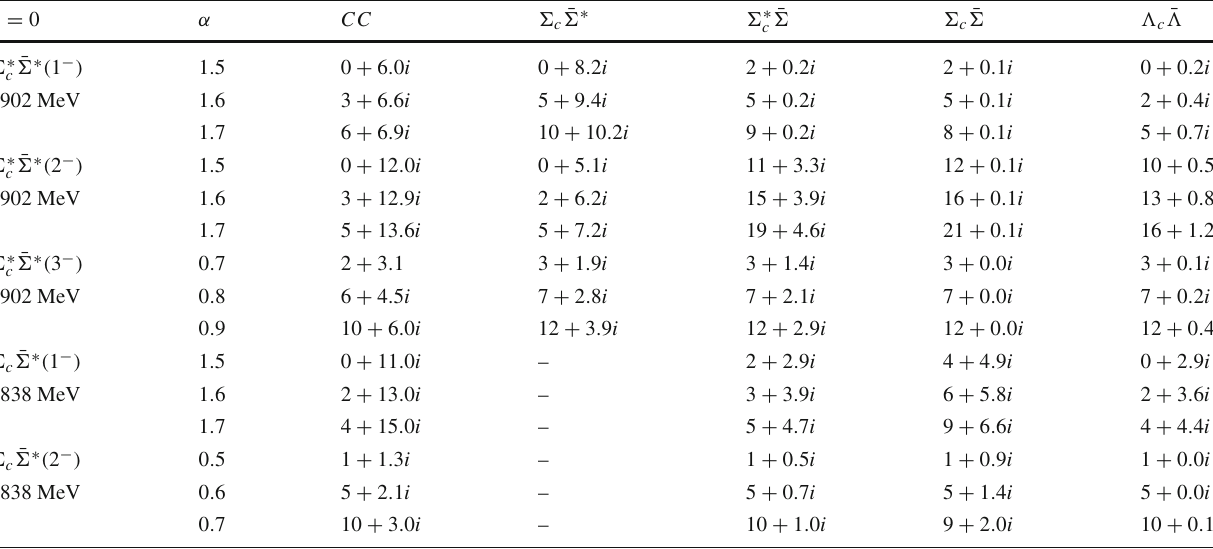
Table 7 The masses and widths of isoscalar charmed-antistrange molecular states at different values of α . Other notations are the same as Table 4